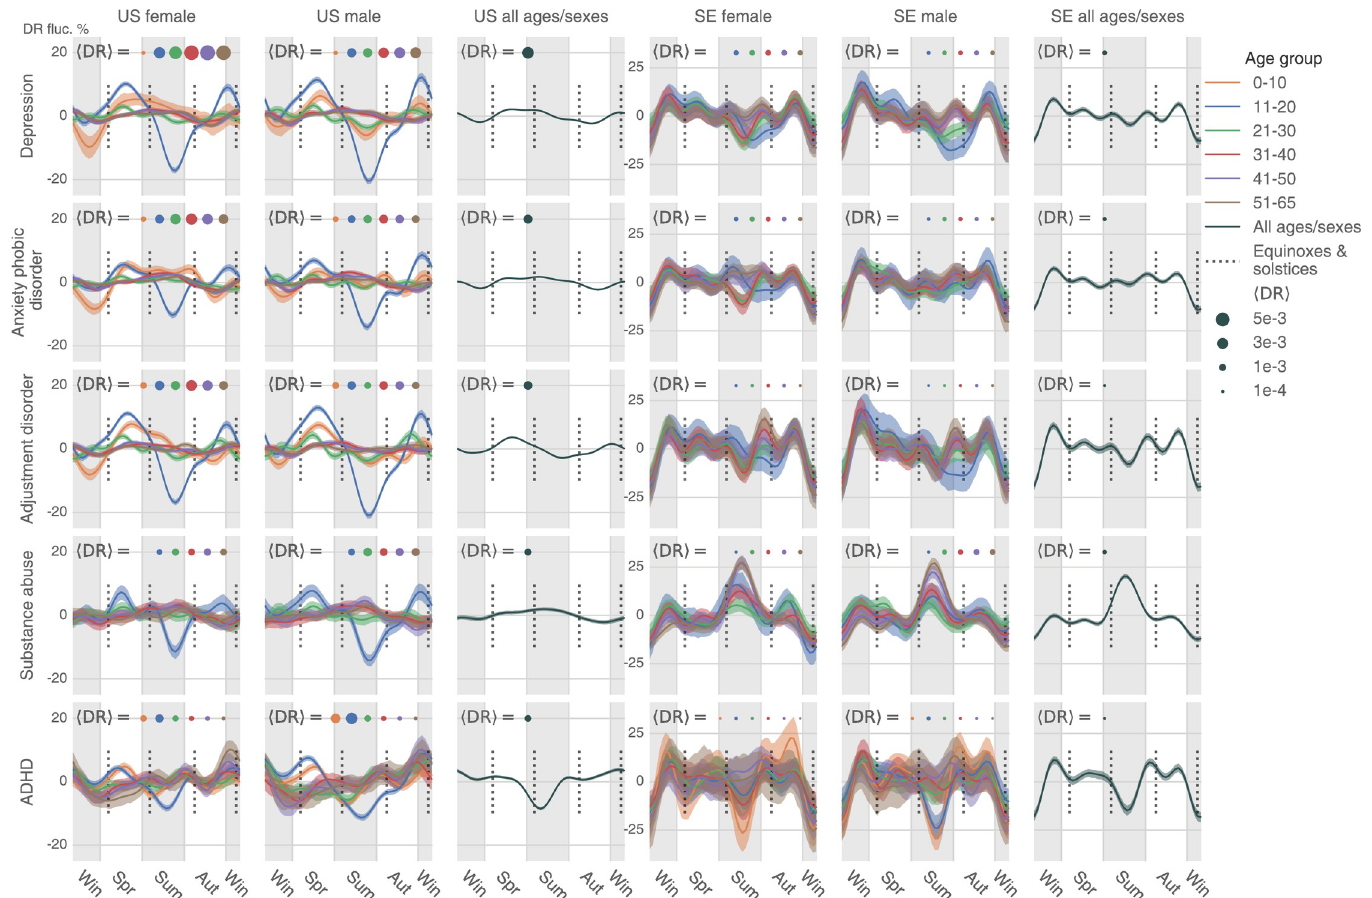
Fig 6. The corrected seasonality plots of the 5 most diagnosed psychiatric diseases in the US and SE: Depression, anxiety and phobic disorder, adjustment disorder, substance abuse, and ADHD. ADHD, attention-deficit/hyperactivity disorder; DR, diagnosis rate; SE,